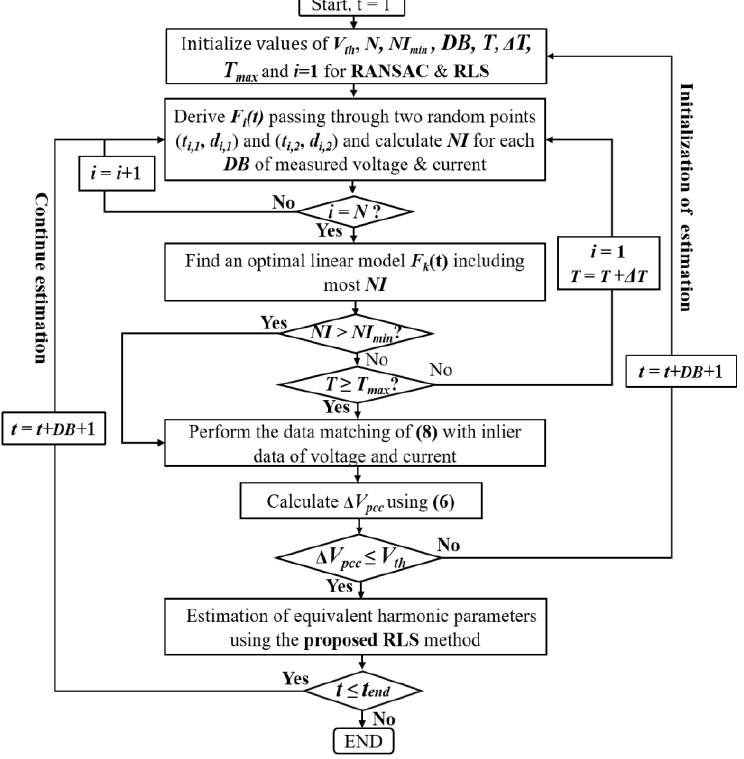
Figure 3. The estimation procedure of equivalent model parameters.